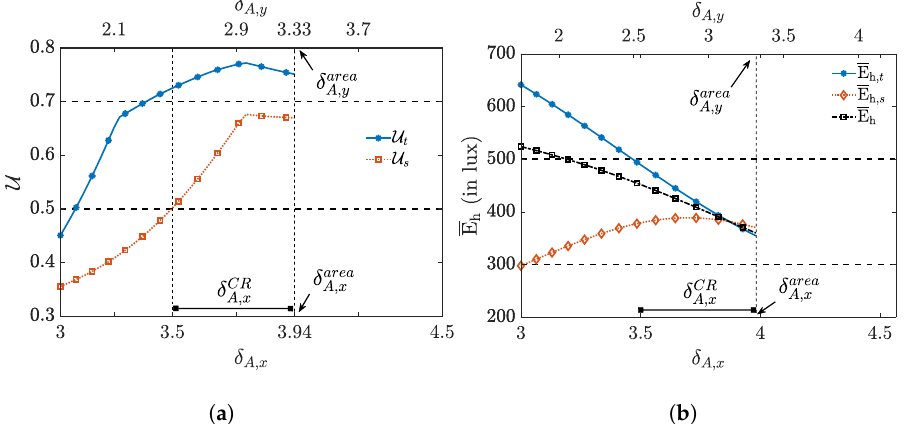
Figure 12. True values of ( a ) uniformity: U t and U s , and ( b ) the horizontal illuminance average: E h, t , E h, s and E h , for X max = 10 m, K S = 1.5, Z max = 2 m, K A = 1, Φ typ v = 270 lm, Φ 1/2 = π